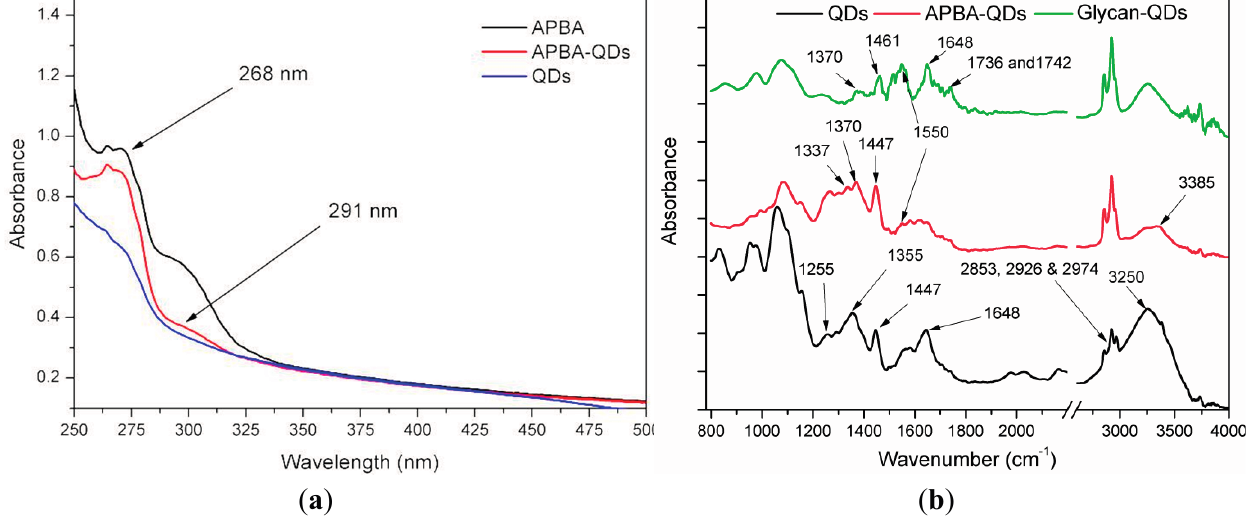
Figure 2. ( a ) Absorbance spectra of QDs with and without APBA conjugation; ( b ) FTIR spectra of bare carboxyl QDs, APBA-QDs and Glycan-QDs